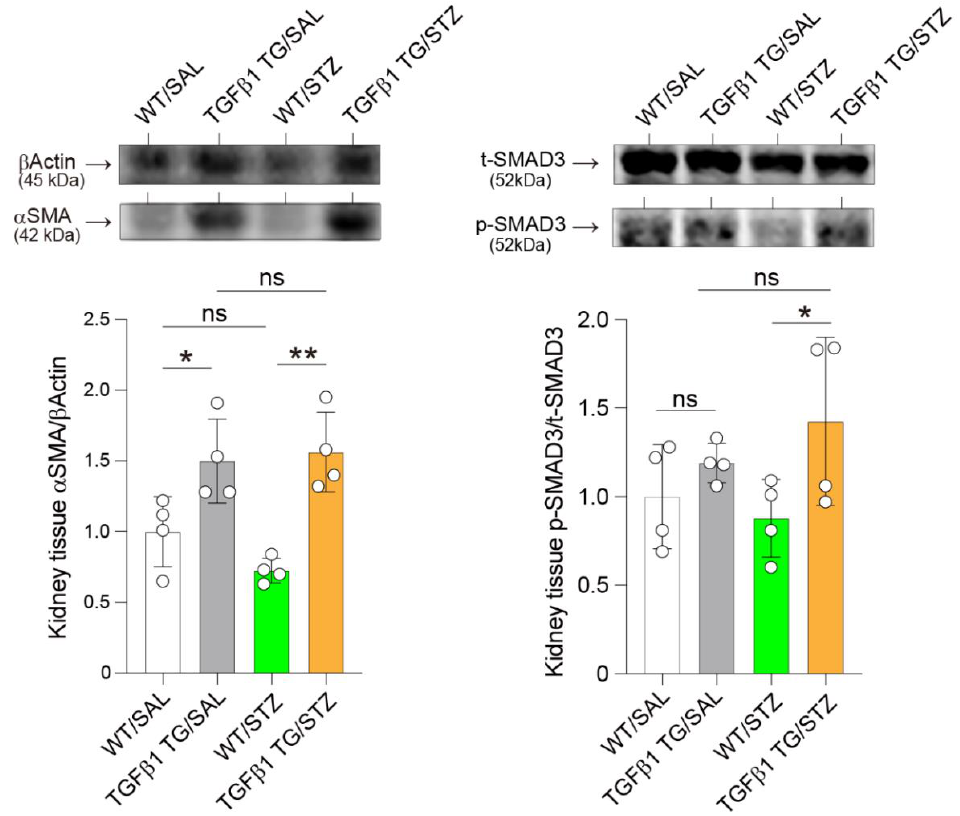
Figure 8. Increased expression of α smooth muscle actin and phosphorylation of SMAD3 in diabetic transforming growth factor β 1 mice. The protein expression of α smooth muscle actin ( α SMA) and the activation of SMAD3 were assessed by western blotting. n = 4 in each group. Data are the mean ± S.D. Statistical analysis by ANOVA with Newman – Keuls ’ test. * p < 0.05; ** p < 0.01.